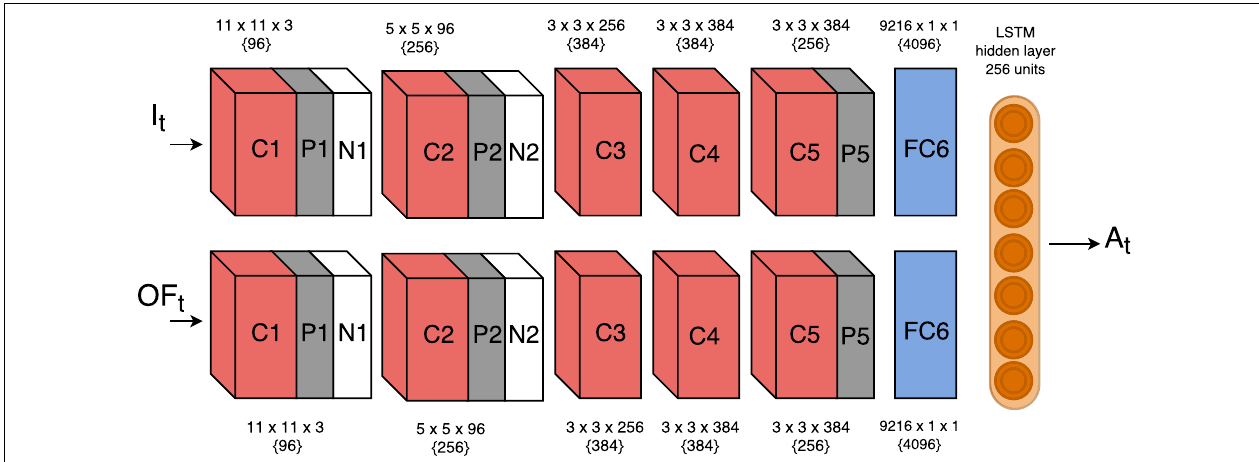
FIGURE 6 | LRCN: a snapshot of the model at time t . I t refers to the frame and OF t the optical flow at t . The video is classified by averaging the output A t over all t .